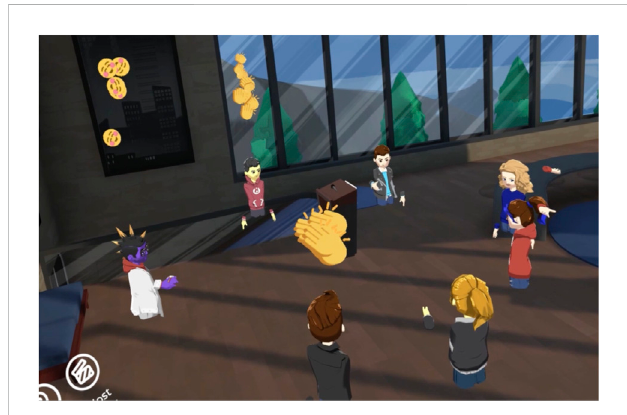
FIGURE 10 This fi gure shows the use of emojis to express emotions in the AltspaceVR